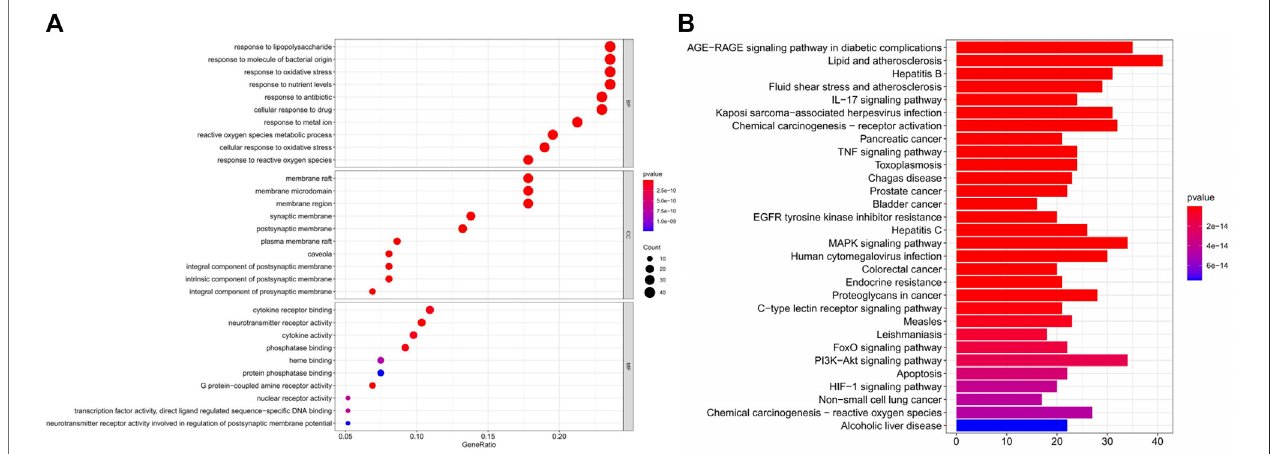
FIGURE 8 | Bubble diagram of GO enrichment analysis of DZXY-Depression genes (A) and the bar plot diagram of KEGG enrichment pathways (B) , respectively.